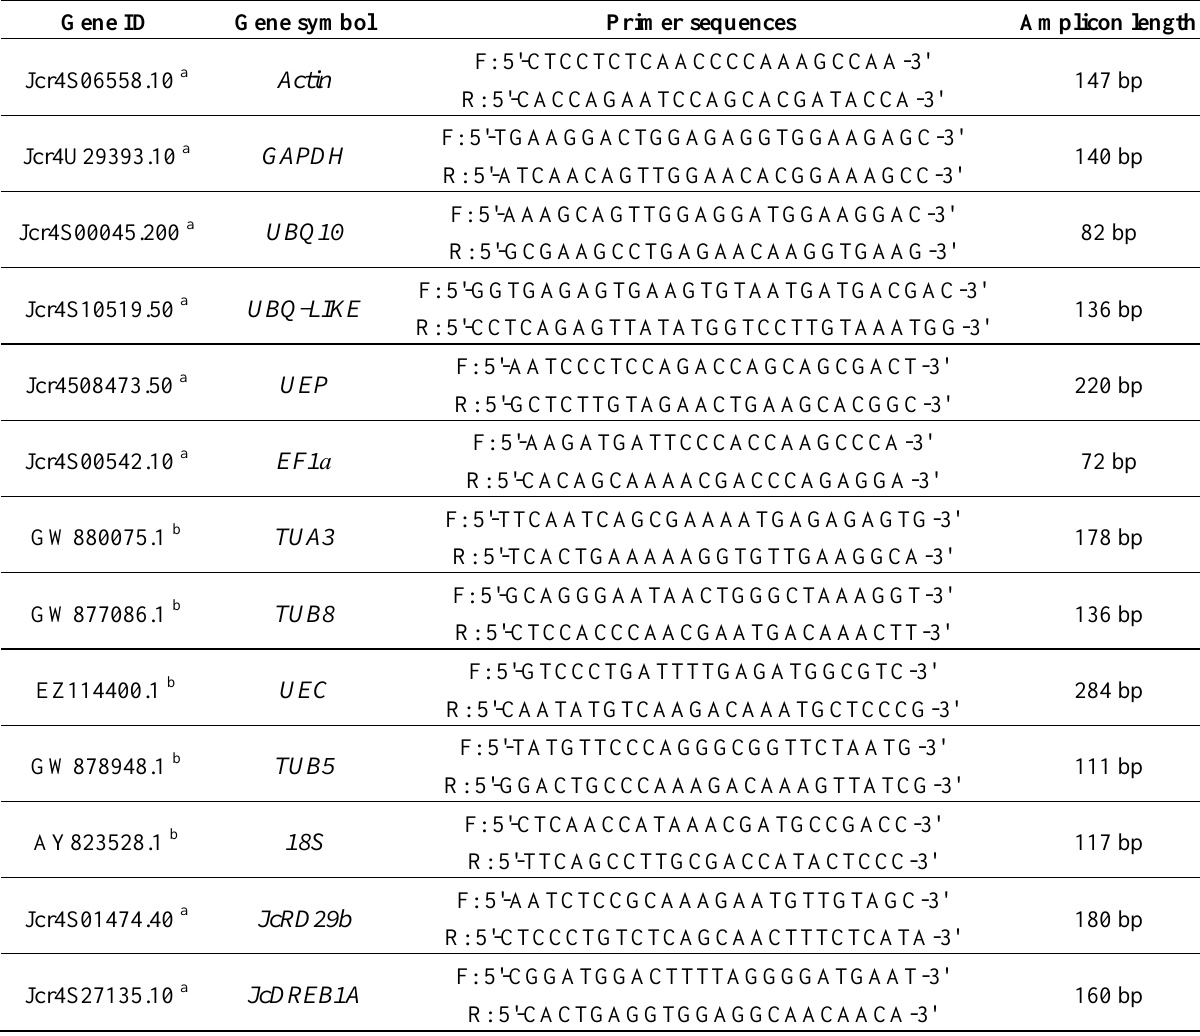
Table 3. Primer sequences, PCR amplicon length of the selected reference genes and stress responsive genes in Jatropha